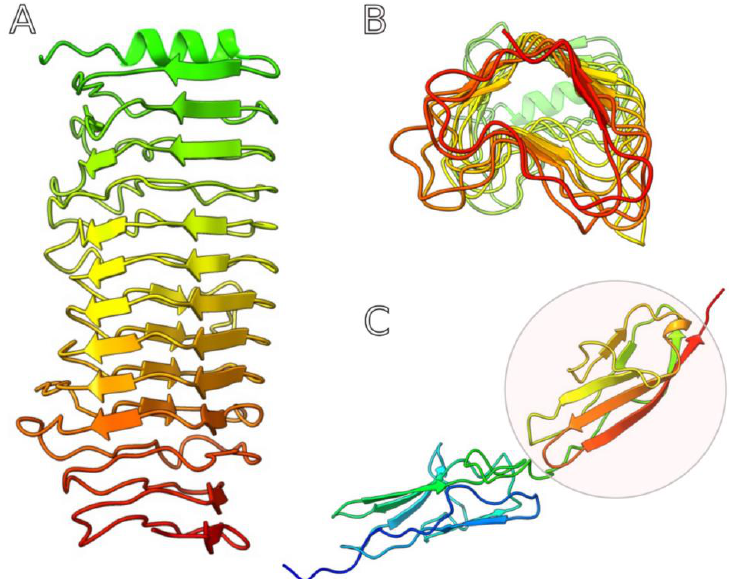
Figure 6. Homology modelling of the phage Arno 160 tail spike central region ( A , B ) and outer capsid protein ( C ), performed with best-fitting HHpred templates (toolkit.tuebingen.mpg.de). The tail spike contains parallel β -helices organized as triangular β -prisms ( B ), and the outer capsid protein contains an Ig-like domain (circled). The models are colored based on rainbow gradient scheme where the N-terminus of the polypeptide chain is colored blue, and the C-terminus is colored red.